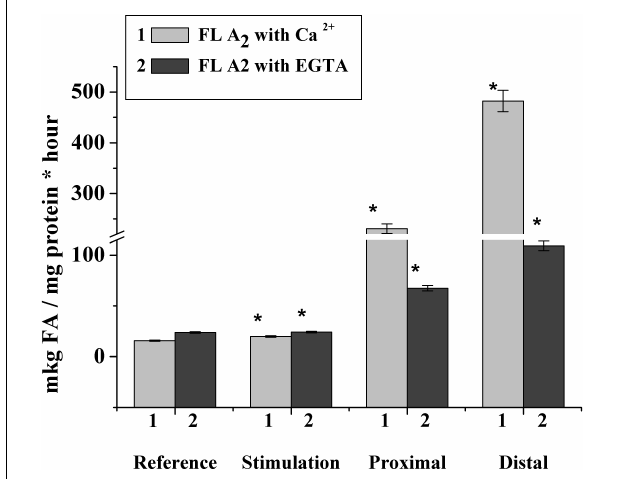
FIGURE 5 | Changes in phospholipase A 2 activity after incubation of the rat myelin nerve in Ca 2 + - or EGTA-containing medium during the electric stimulation and damage of the nerve; ∗ significance of difference with respect to control, p < 0.05.